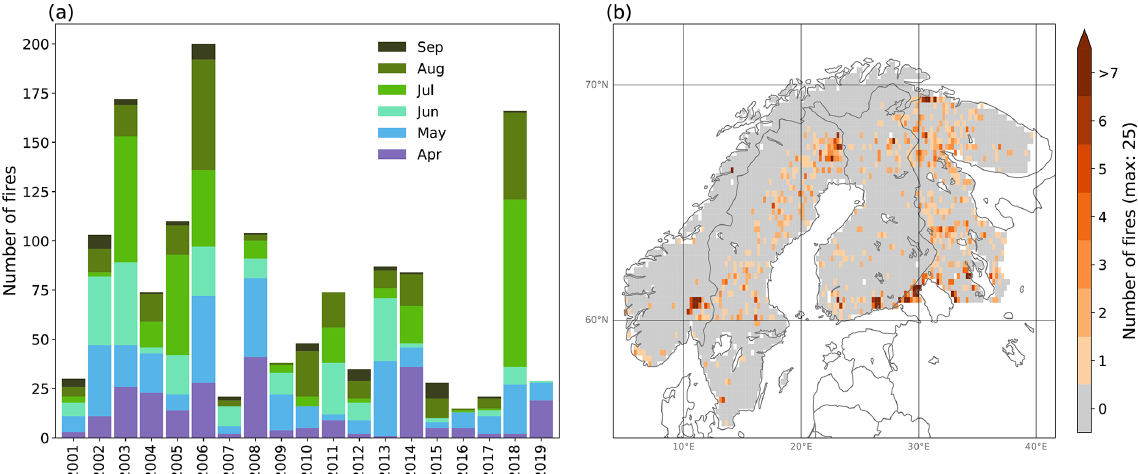
Figure 2. Distribution of fire occurrences in the satellite-based target variable over (a) time (month and year) and (b) space (0.25 ◦ resolution).